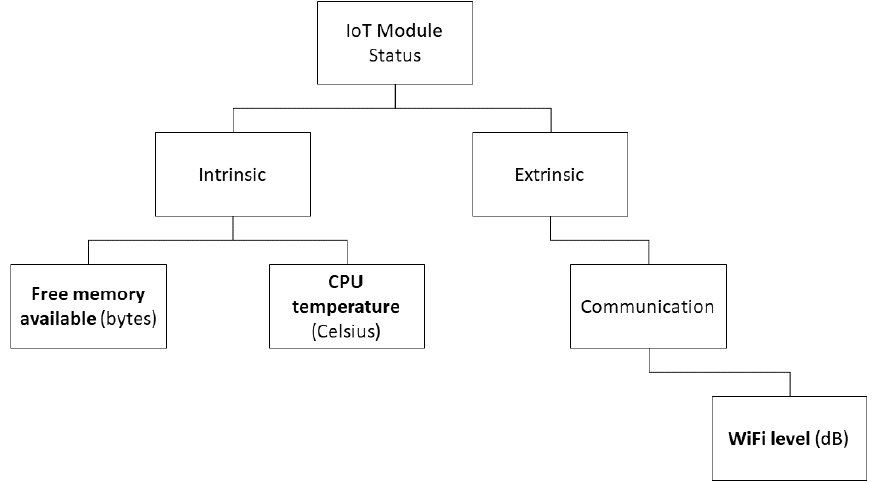
Figure 5. Example of IoT module status collected metrics.